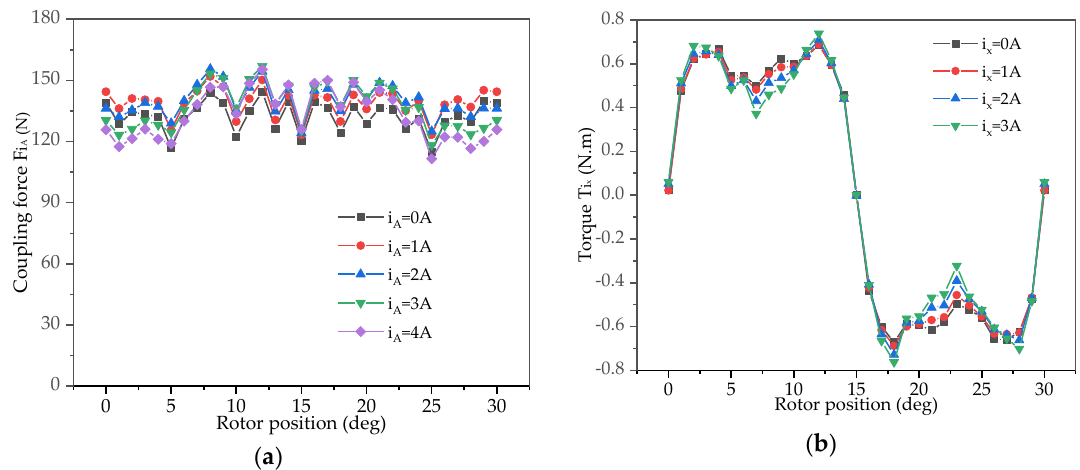
Figure 3. Coupling characteristics between the torque and suspension performance of the proposed machine: ( a ) suspension force characteristic with a fixed current in suspension windings and various currents in torque windings; ( b ) torque characteristic with a fixed current in torque windings and various currents in suspension windings.